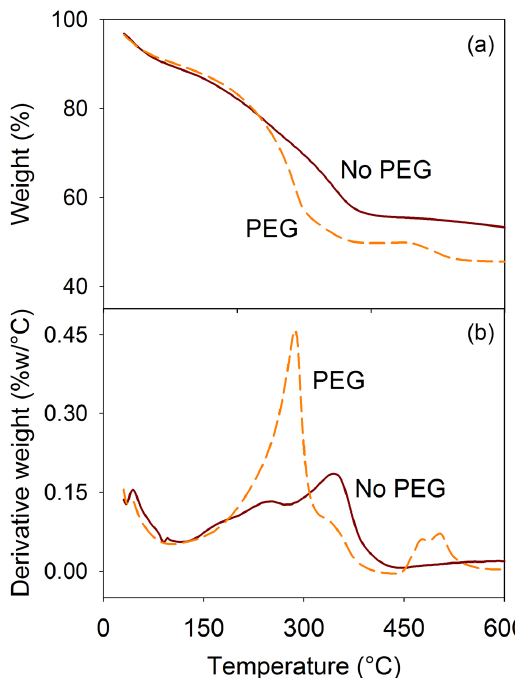
Figure 3. (a) Thermogravimetric analysis (TGA) of the xerogels, with and without PEG. (b) Differential thermogravimetry (DTG) Figure 2. Viscosity vs. Time for the TiO of the xerogels, with and without sols with and without PEG. 2